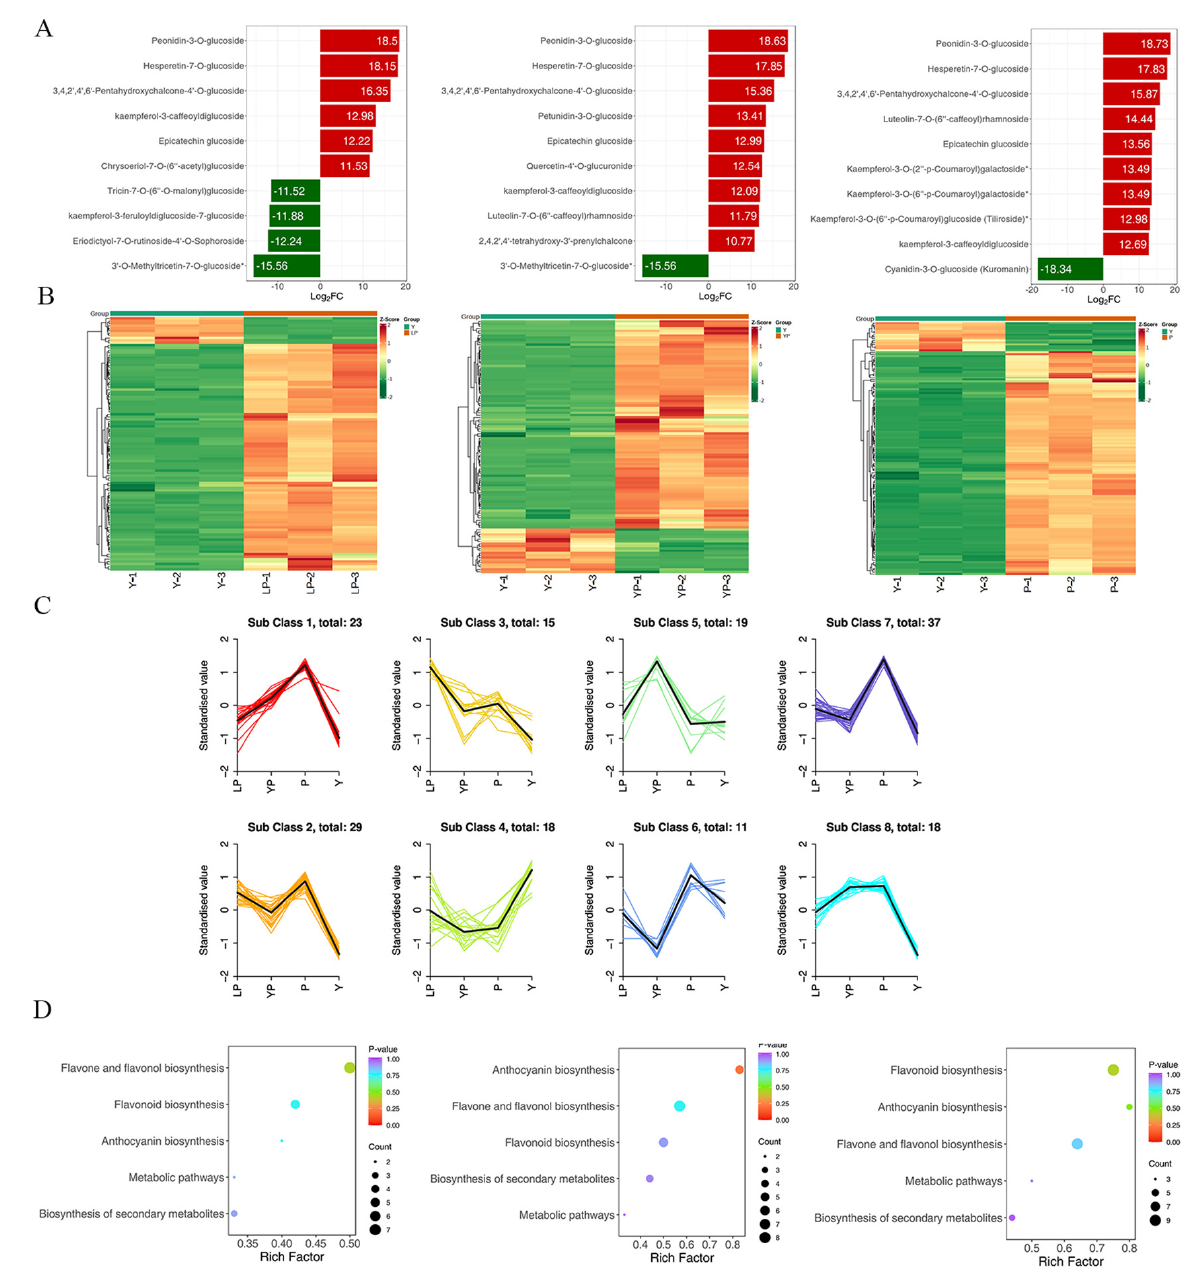
Figure 5. ( A ) Differential metabolites bar graph. Horizontal coordinates are log2FC of differential metabolites and vertical coordinates are differential metabolites. Red represents upregulated differ- Figure 5. ( A ) Di ff erential metabolites bar graph. Horizontal coordinates are log2FC of di ff erential ential metabolites, and green represents downregulated differential metabolites. From left to right, metabolites and vertical coordinates are di ff erential metabolites. Red represents upregulated di ff er- Y vs. LP, Y vs. YP, Y vs. P. ( B ) Differential metabolites clustering heat map. From left to right, Y ential metabolites, and green represents downregulated di ff erential metabolites. From left to right, vs. LP, Y vs. YP, Y vs. P. ( C ) K means analysis. ( D ) KEGG analysis of differential metabolites. The Y vs. LP, Y vs. YP, Y vs. P. ( B ) Di ff erential metabolites clustering heat map. From left to right, Y vs. horizontal coordinate indicates the Rich factor of each pathway, the vertical coordinate is the name of LP, Y vs. YP, Y vs. P. ( C ) K means analysis. ( D ) KEGG analysis of di ff erential metabolites. The hor- the pathway, and the color of the dot is the p -value, the redder it is, the more significant the analysis. The size of the dots represents the number of differential metabolites. From left to right, Y vs. LP, Y vs. YP, Y vs.